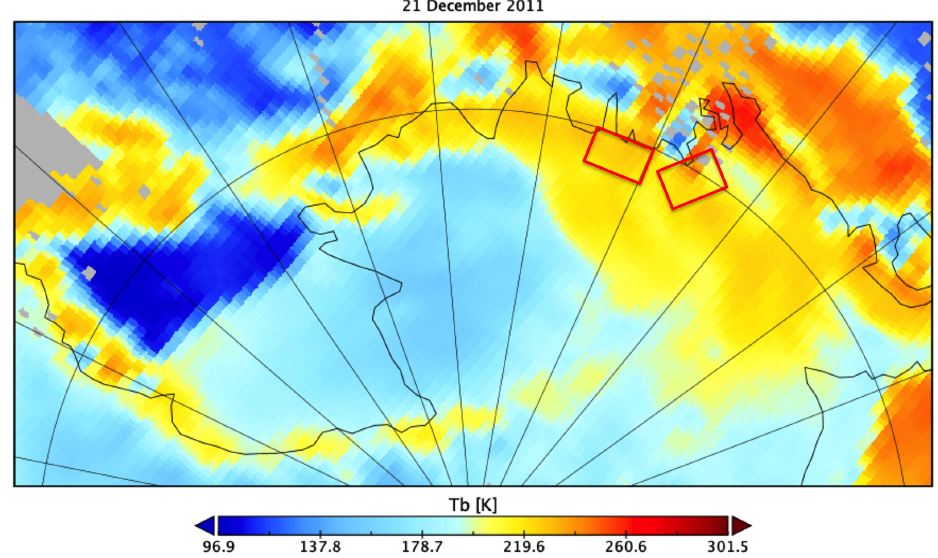
Figure B4. SSMIS horizontally polarized 19.35GHz brightness temperature over West Antarctica and the RIS on 21 December 2011, with red boxes denoting the Thwaites Glacier (left) and Pine Island Glacier (right) bounding regions.